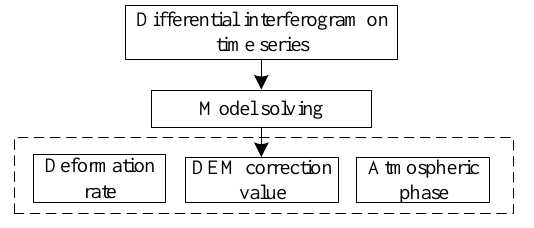
Figure 5. Flow chart of phase unwrapping